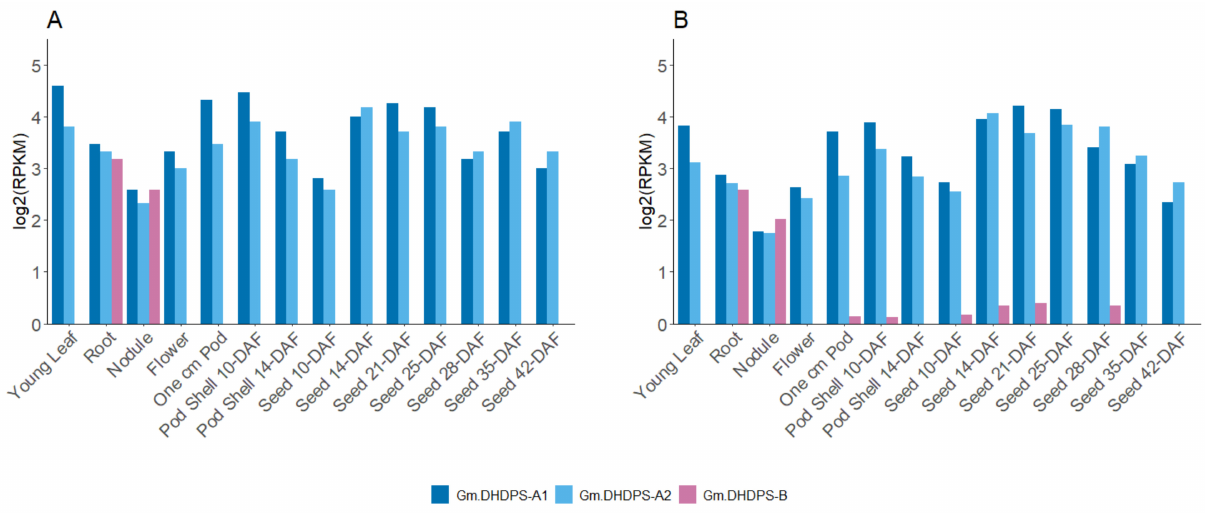
Figure 4. Bar chart comparison between RPKM values ( Y -axis) of the three DHDPS genes in 14 differ- ent plant samples ( X -axis) as ( A ) publicly available at https://soybase.org/, accessed on 21 June 2022 and ( B ) the RPKM values obtained by re-analysis [31]. All RPKM values are